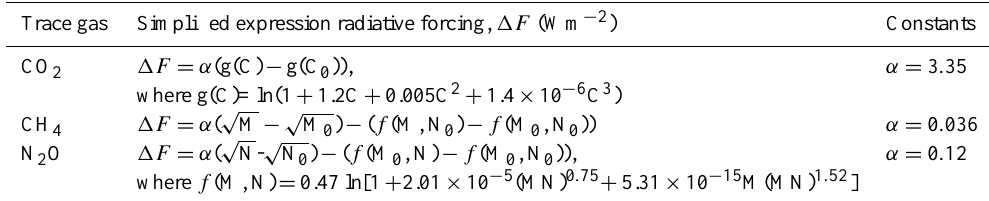
Table 3. Simplified expressions for calculation of radiative forcing due to CO 2 , CH 4 , N 2 O. C is CO 2 in ppmv, M is CH 4 in ppbv, and N is N 2 O in ppbv. The subscript 0 denotes the unperturbed GHG concentration of PI.